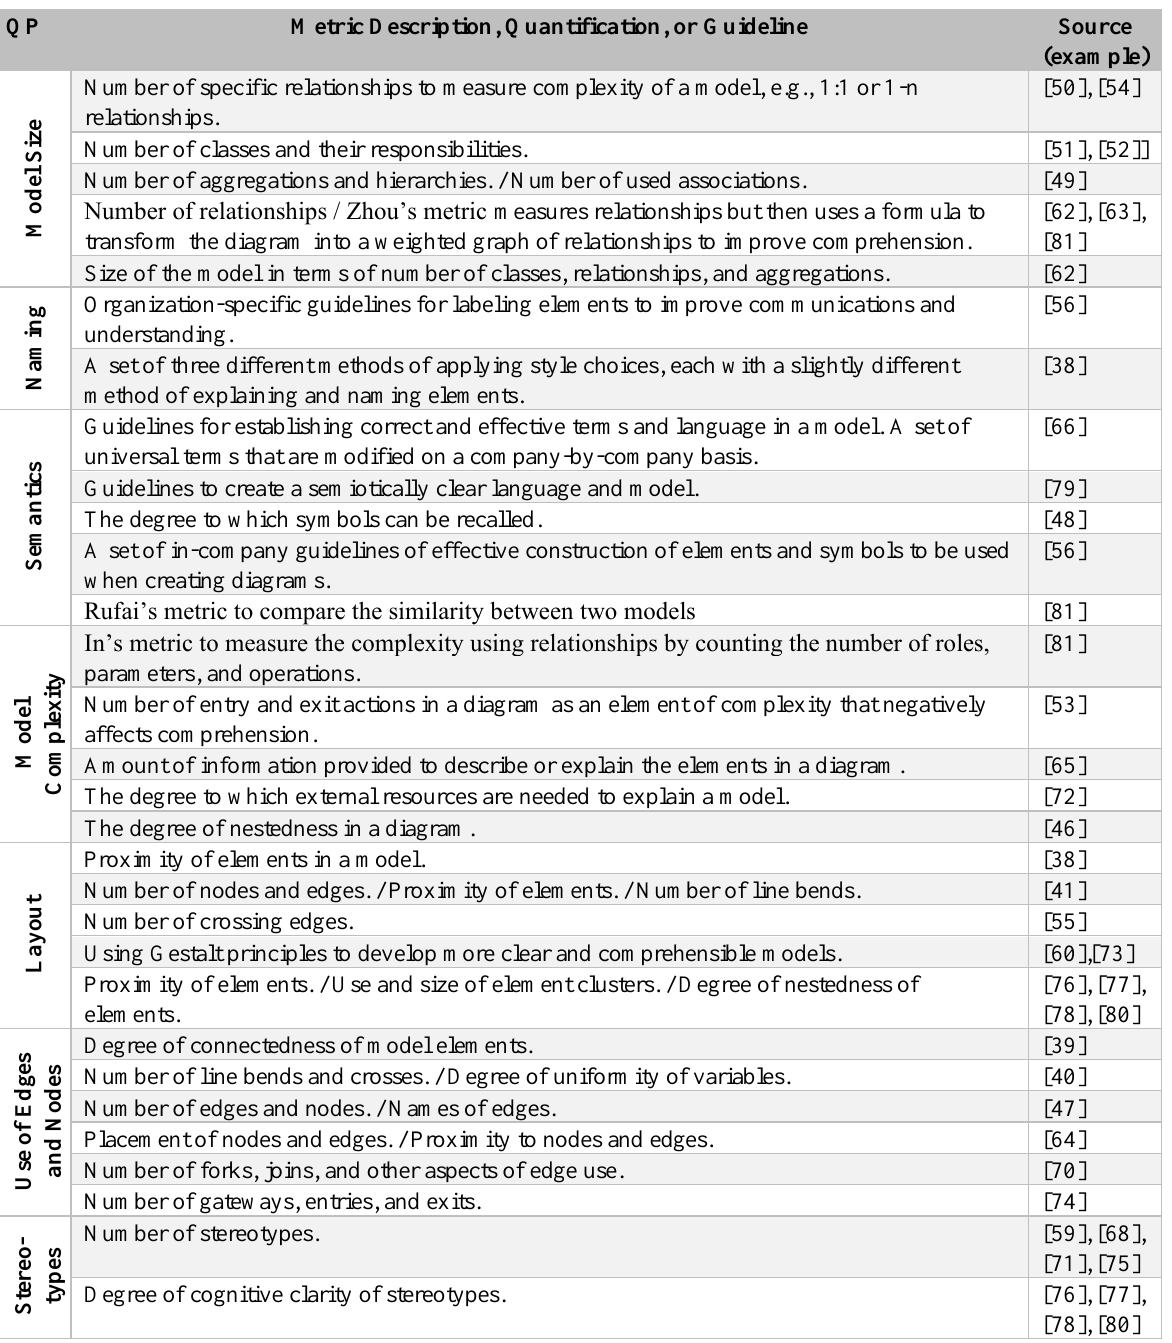
Table 2. Metrics for model comprehension, quality property (QP) they pertain to, and paper source QP Metric Description, Quantification, or Guideline Source ze S i e l d o M